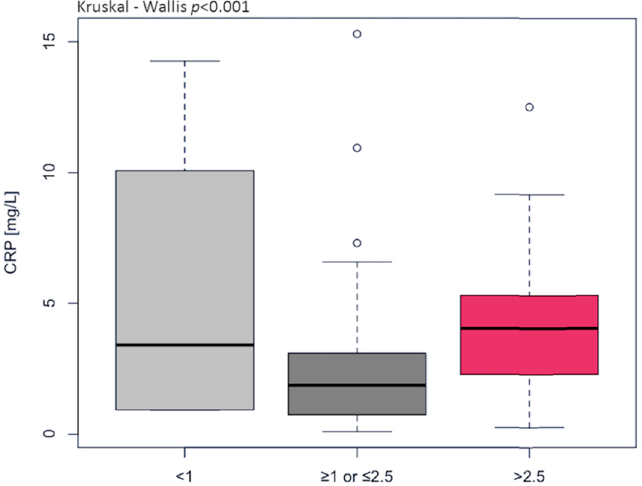
Figure 1. The levels of C-reactive protein (CRP) differentiated the immune risk profile (IRP) expressed as the ratio of total CD4 + to total CD8 + (normal ≥ 1 or ≤ 2.5, inverted < 1, high > 2.5). Table 4. Inflammatory and endothelium-specific variables.